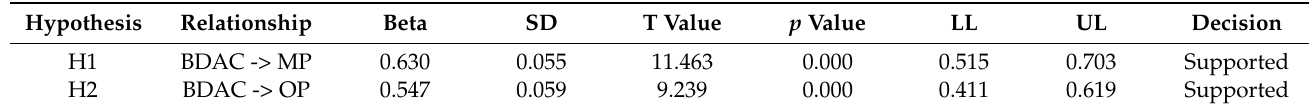
Table 4. Results summary for the direct effect testing.